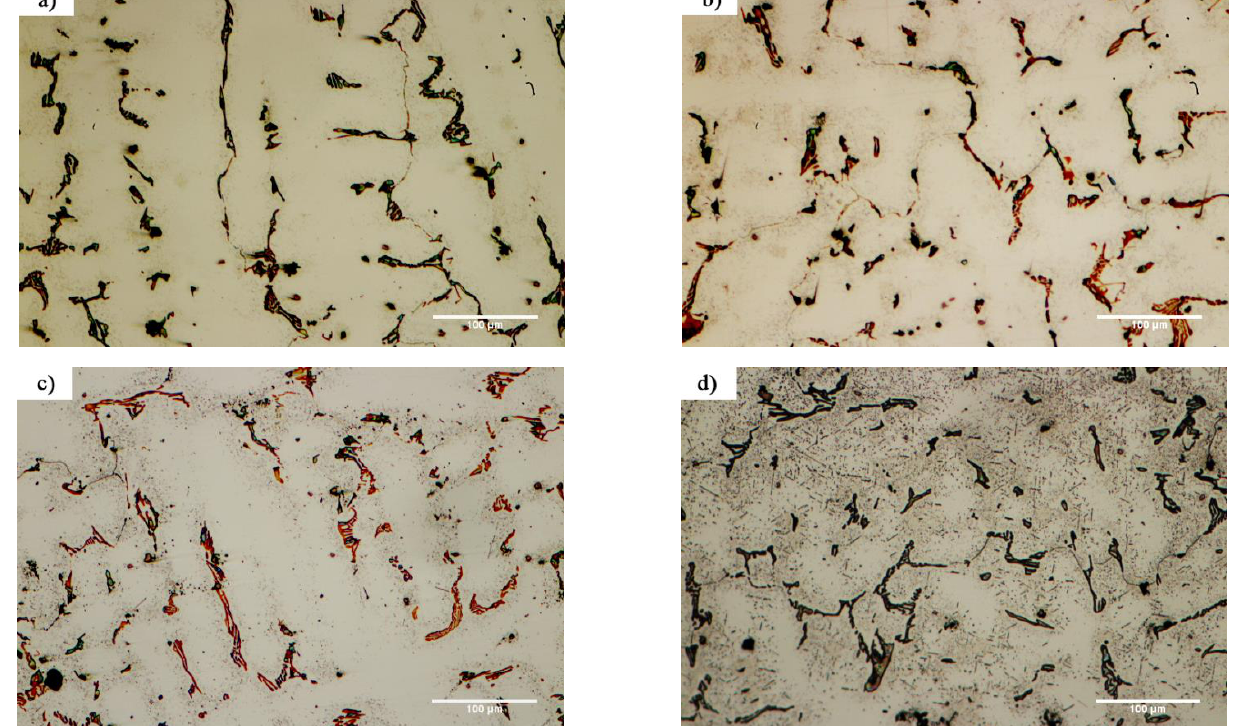
Figure 11. Optical microscopy of microstructural evolution of X-45 at a constant time of 10 min and different temperatures: ( a ) 1010 °C, ( b ) 1050 °C, ( c ) 1100 °C, and ( d ) 1150 °C.